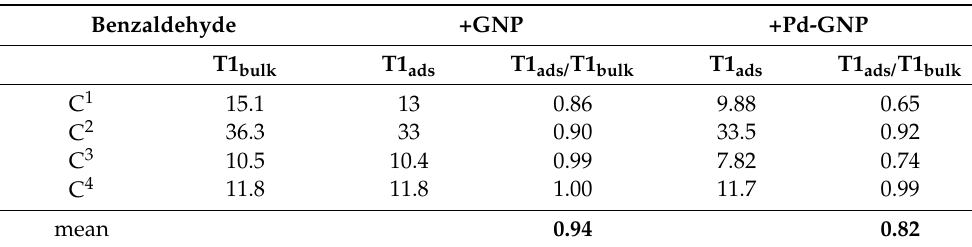
Table 4. Benzaldehyde in p -Xylene-d 10 : T1 bulk and T1 ads resulting from the analysis of the inversion recovery curves (Figures S1–S3) from 13 C NMR spectra in high-field (600 MHz). (C indicates each benzaldehyde carbon atom as in Figure 4).